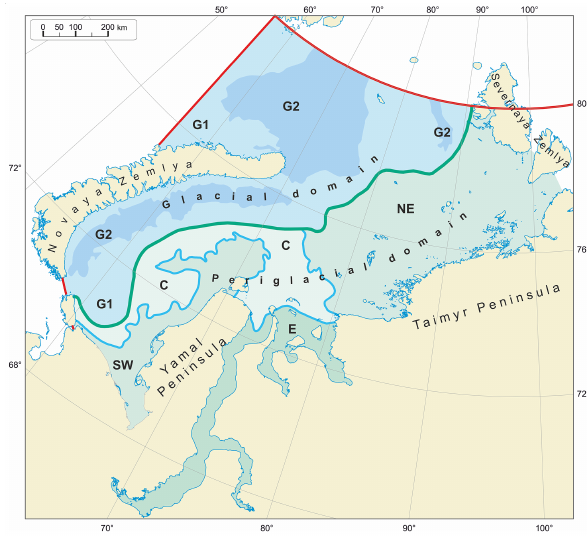
Figure 3. Zoning of the Kara shelf according to its geological his- tory for 125kyr. Abbreviations are explained in the text and in Ta- ble 1. The red line is the region boundary in this